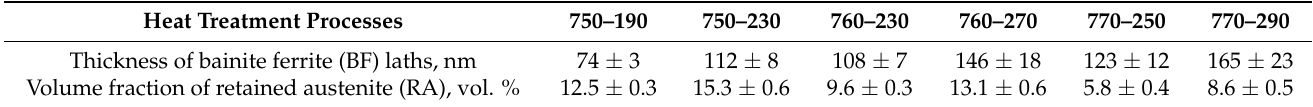
Table 1. Thickness of bainite ferrite laths and content of retained austenite after different